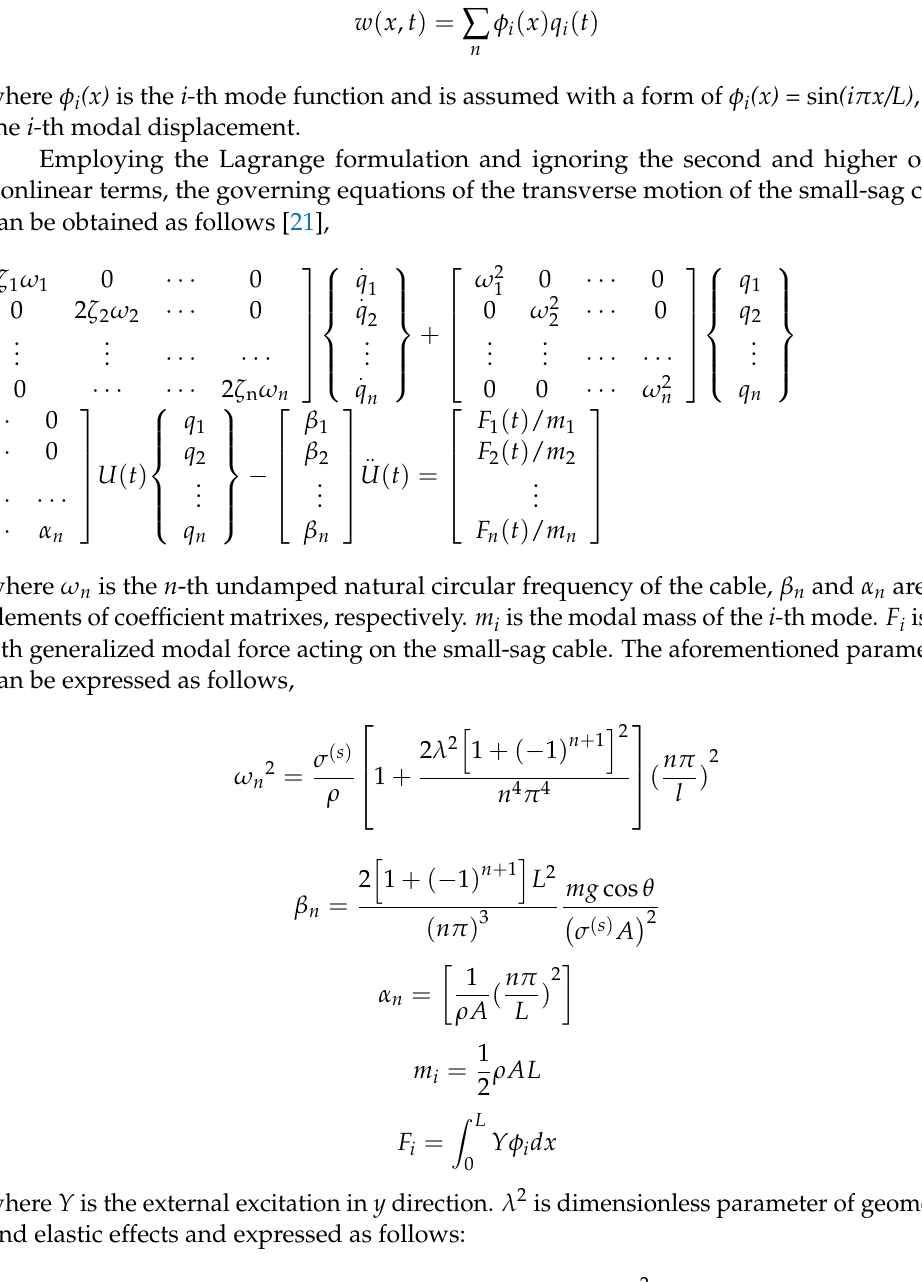
Figure 1. Mechanical model of cable vibration control system. The separation of variables method is employed to obtain the in-plane vertical dis- placement of the cable as the following